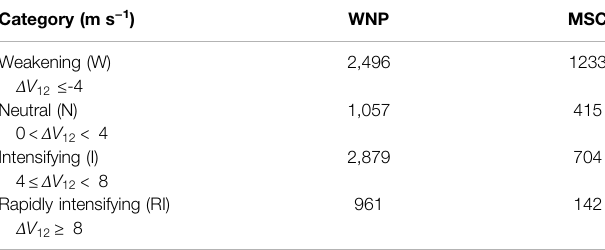
TABLE 3 | Intensity change categories, de fi nitions, and sample sizes for TCs over the WNP and the MSC,